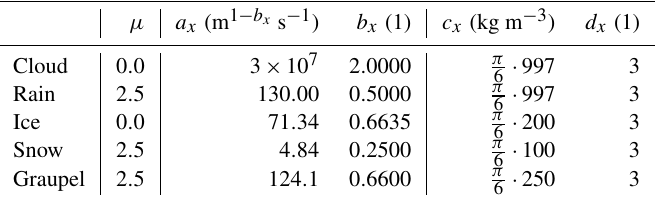
Table 2. Parameters used for the representation of the different hydrometeor types ( x : cloud, rain, ice, snow, and graupel). The size distribu- tions of all hydrometeors are described as gamma distributions with a fixed curvature µ x . The relation between particle mass D x and particle diameter m x is described by m x = c x · D d x x ; the relation between D x and the terminal fall velocity v x by v x = a x D b x x